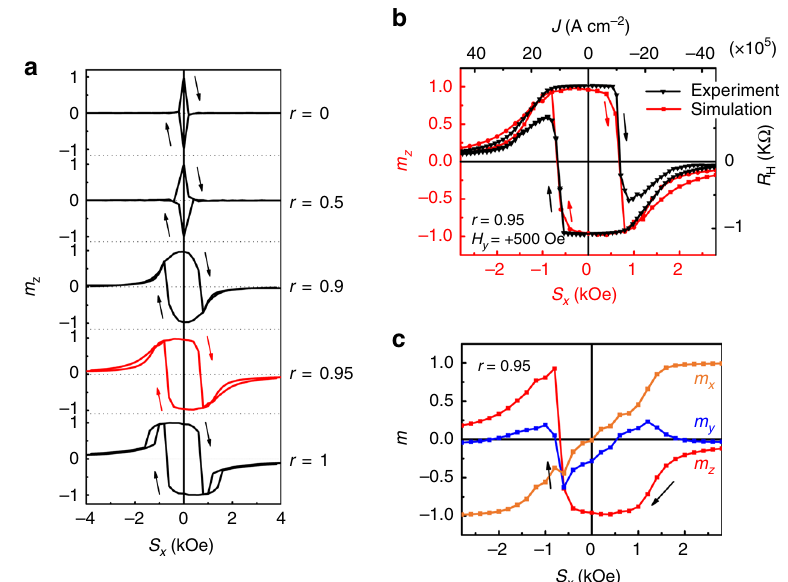
Fig. 5 LLG simulation results and comparison with experimental results. a Simulated SOT switching with different r values of 0, 0.5, 0.9, 0.95 and 1. The parameters used here are H y = 500 Oe, H an = 2.13 kOe and α = 0.05. b Simulated SOT switching at r = 0.95 and experimental results with H y = 500 Oe. Note that the direction of the J axis is reversed because the signs of J and S x are opposite [e.g., when J > 0, S x (or σ x ) < 0, as shown in Fig. 2c]. c Calculated values of m x , m y and m z as functions of S x . (Source data are provided as a Source Data fi